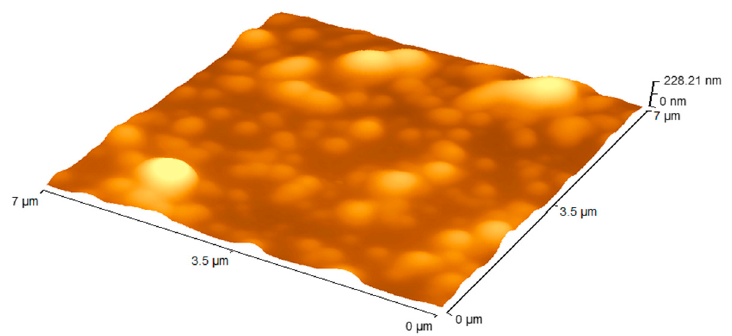
Figure 1. Atomic force microscopy (AFM) topography images of a representative sample of the × 7 µ m 3D rendition. nanoparticle formulations tested, 7 µm × 7 µm 3D rendition. nanoparticle formulations tested, 7 µ m